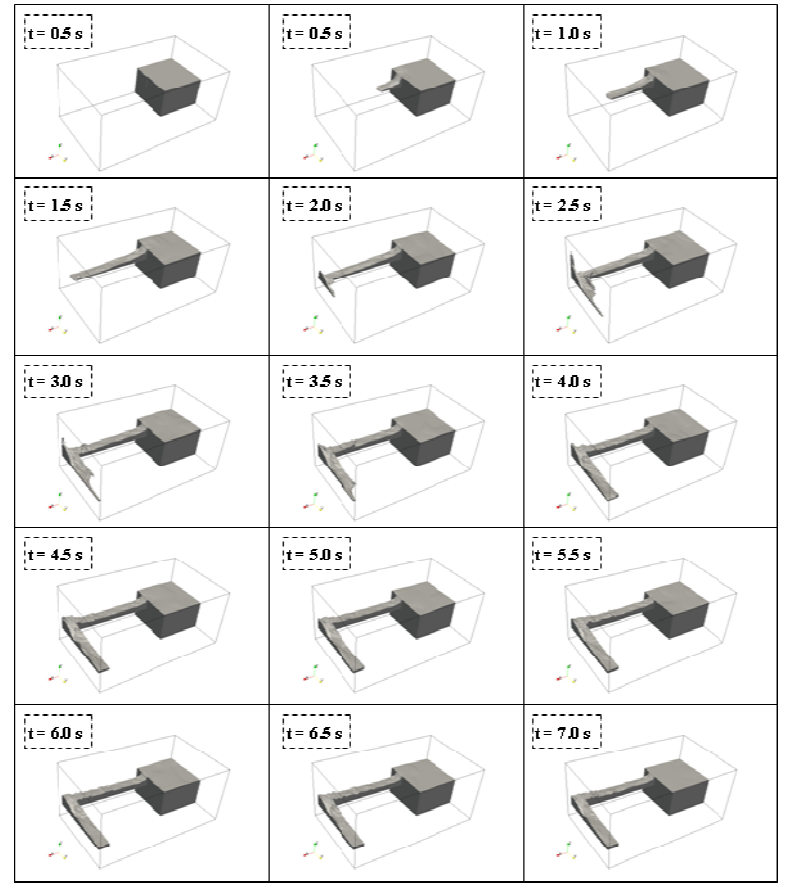
Fig. 16. Dam break over a 90 ◦ bend test: selected frames from 3-D model